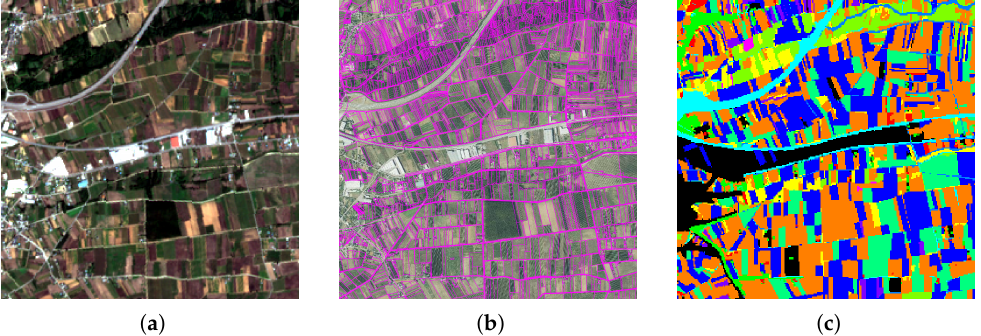
Figure 3. Cropped image and ground truth checking for UOS2. ( a ) cropped image of 256 × 256 pixels from a Sentinel-2 image, ( b ) SIGPAC visor of the same region , ( c ) ground truth